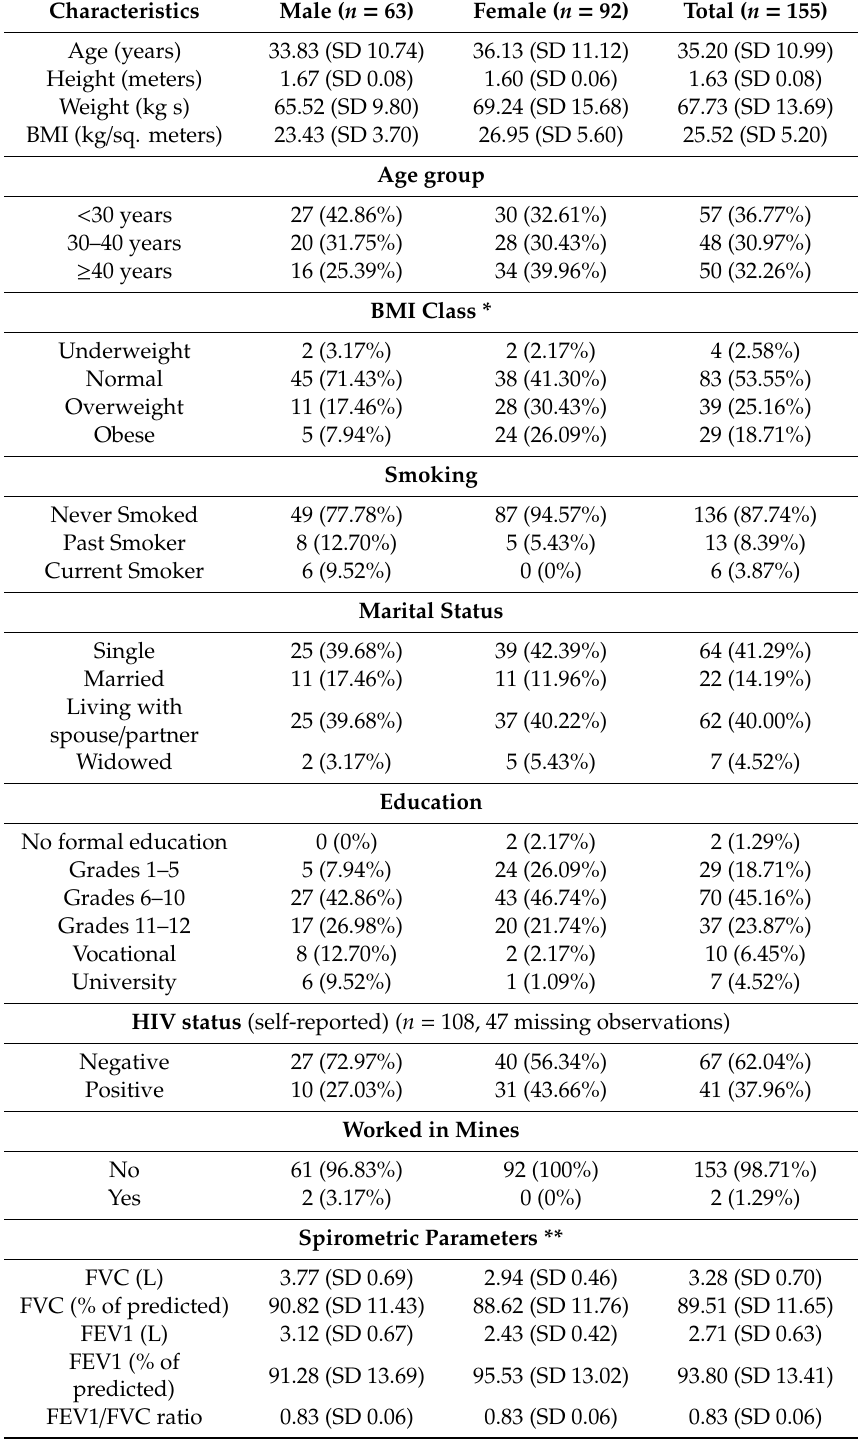
Table 1. Anthropometric, demographic and spirometric characteristics of the participants.